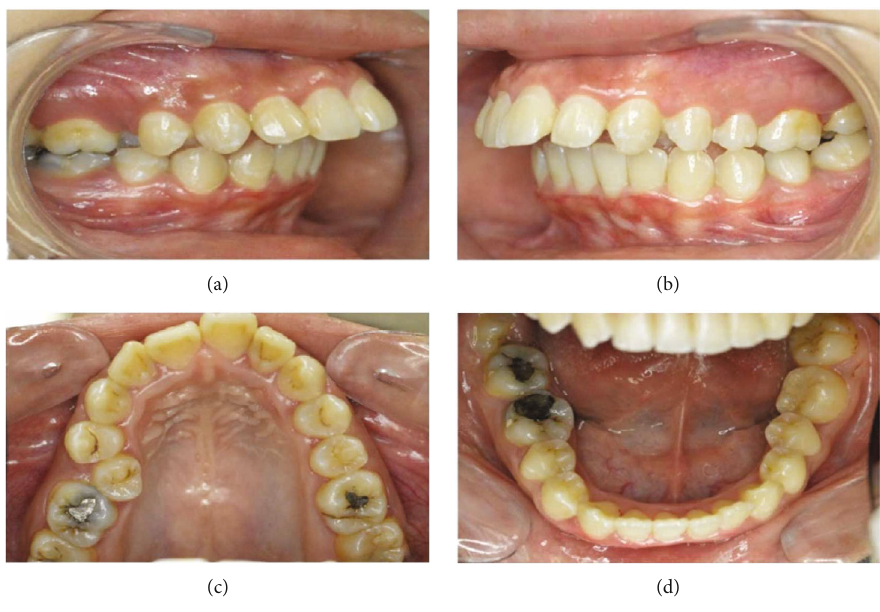
Figure 1: (a – d) Pretreatment intraoral